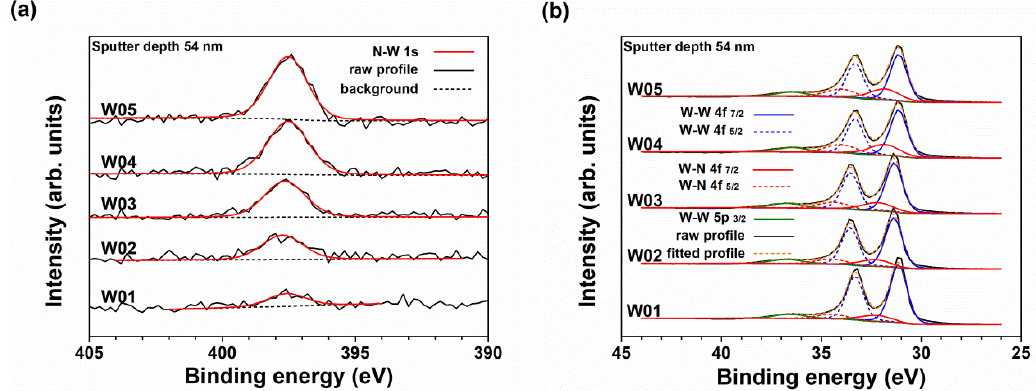
Figure 2. X-ray photoelectron spectroscopy (XPS) signals of ( a ) N 1 s and ( b ) W 4f of Batch W films. Table 2. XPS analysis results of W–N films at depths of 27, 36, 45, and 54 nm.